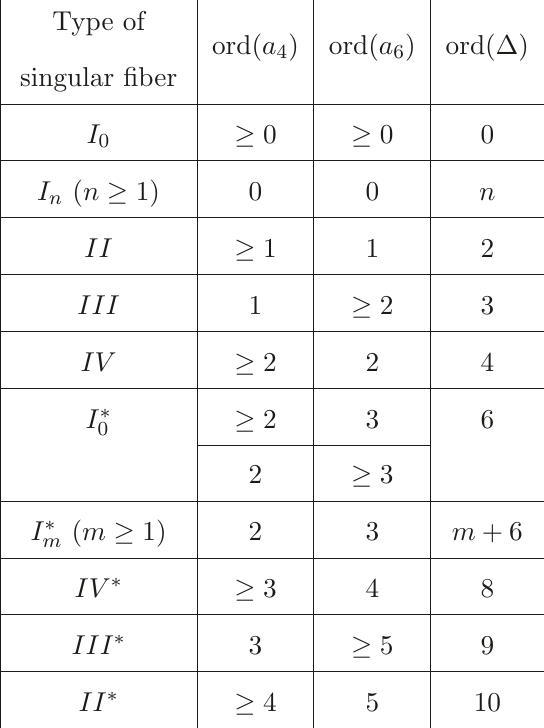
Table 2 . Vanishing orders of the coefficients, and the discriminant ∆, of the Weierstrass equation y 2 = x 3 + a 4 x + a 6 , and the corresponding types of the singular